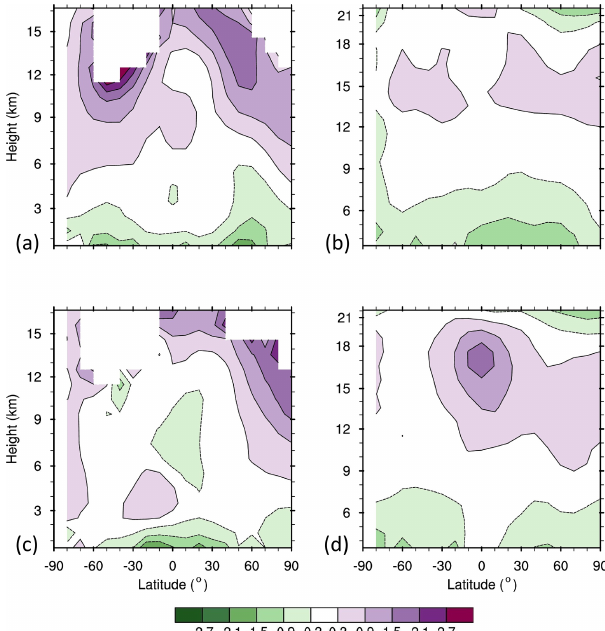
Figure 3. Latitudinal and height distributions of Mie biases (a, c) and Rayleigh biases (b, d) (color scale; ms − 1 ) in ascending (a, b) and descending (c, d)